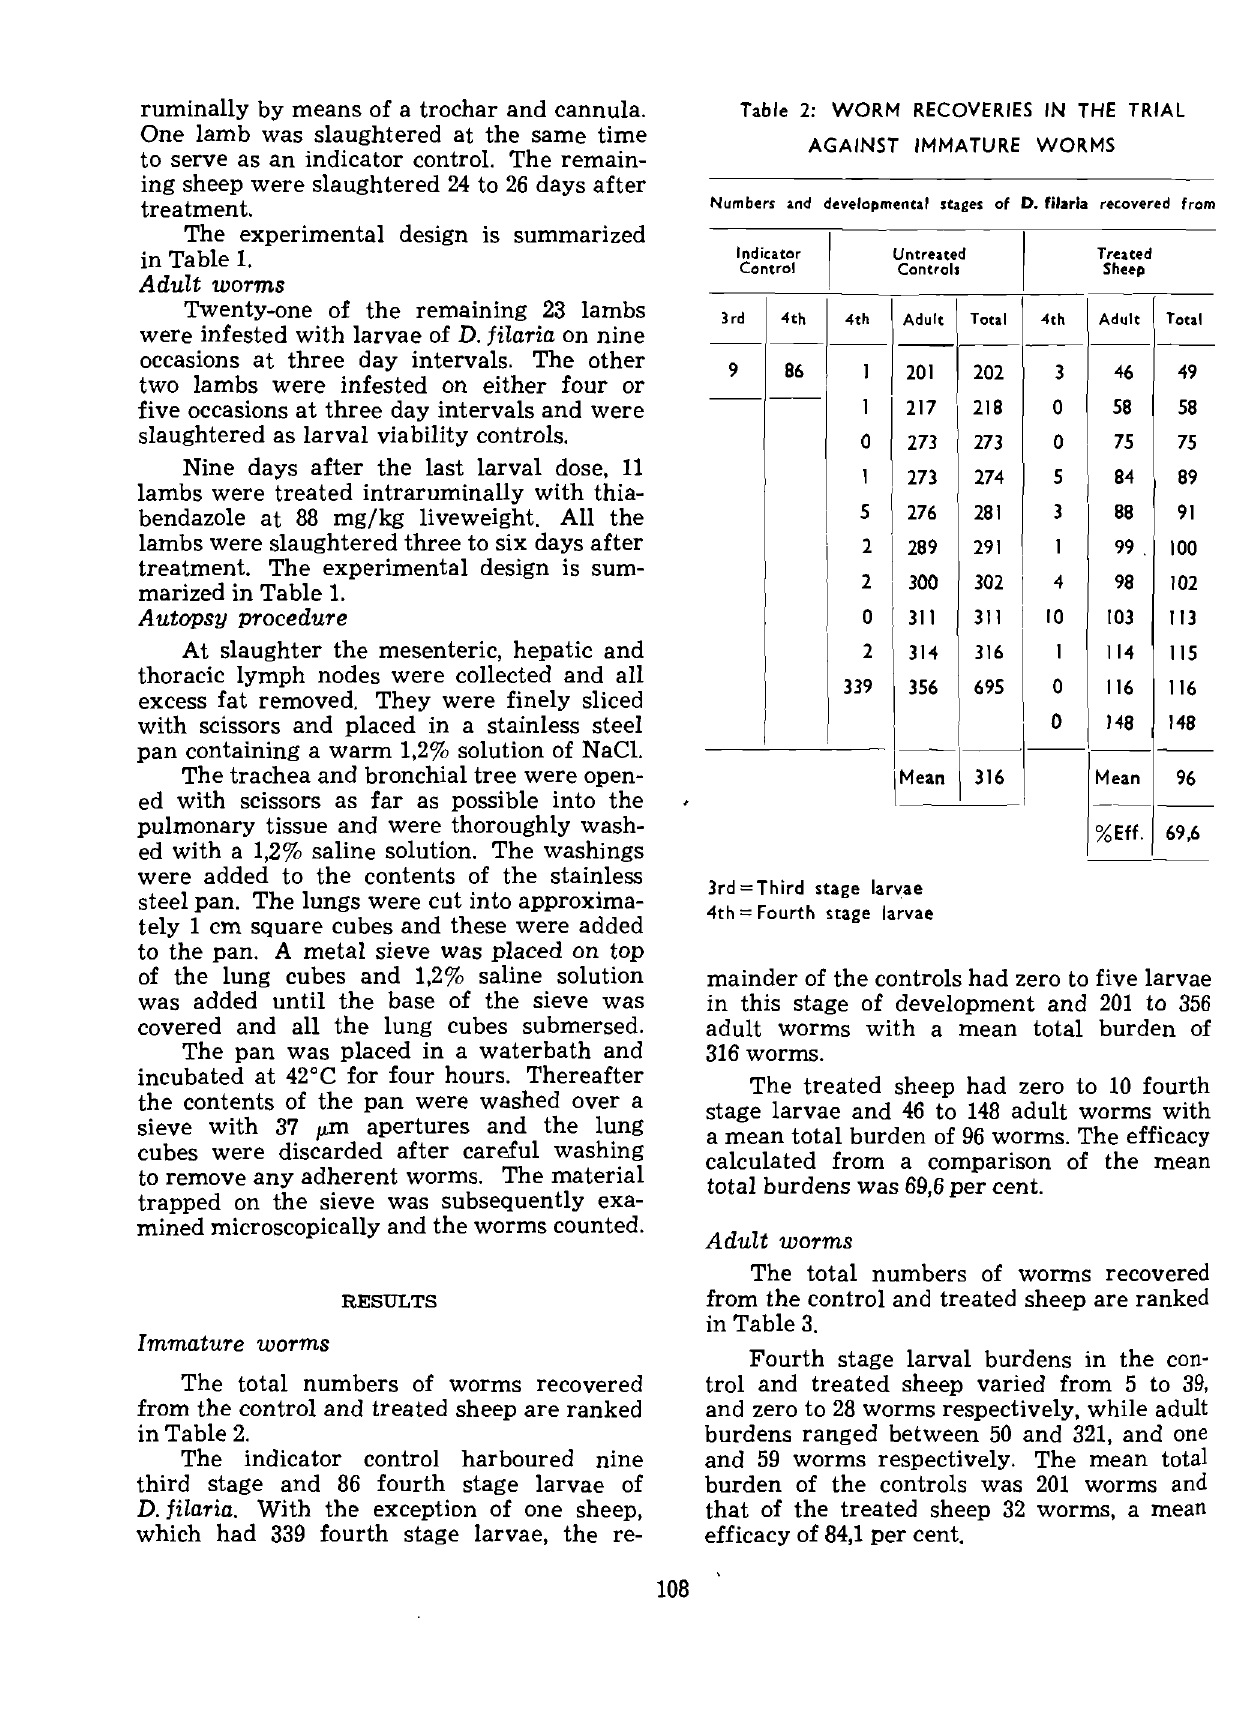
Table 2: WORM RECOVERIES IN THE TRIAL AGAINST IMMATURE WORMS Numbers and developmental stages of D. filaria recovered